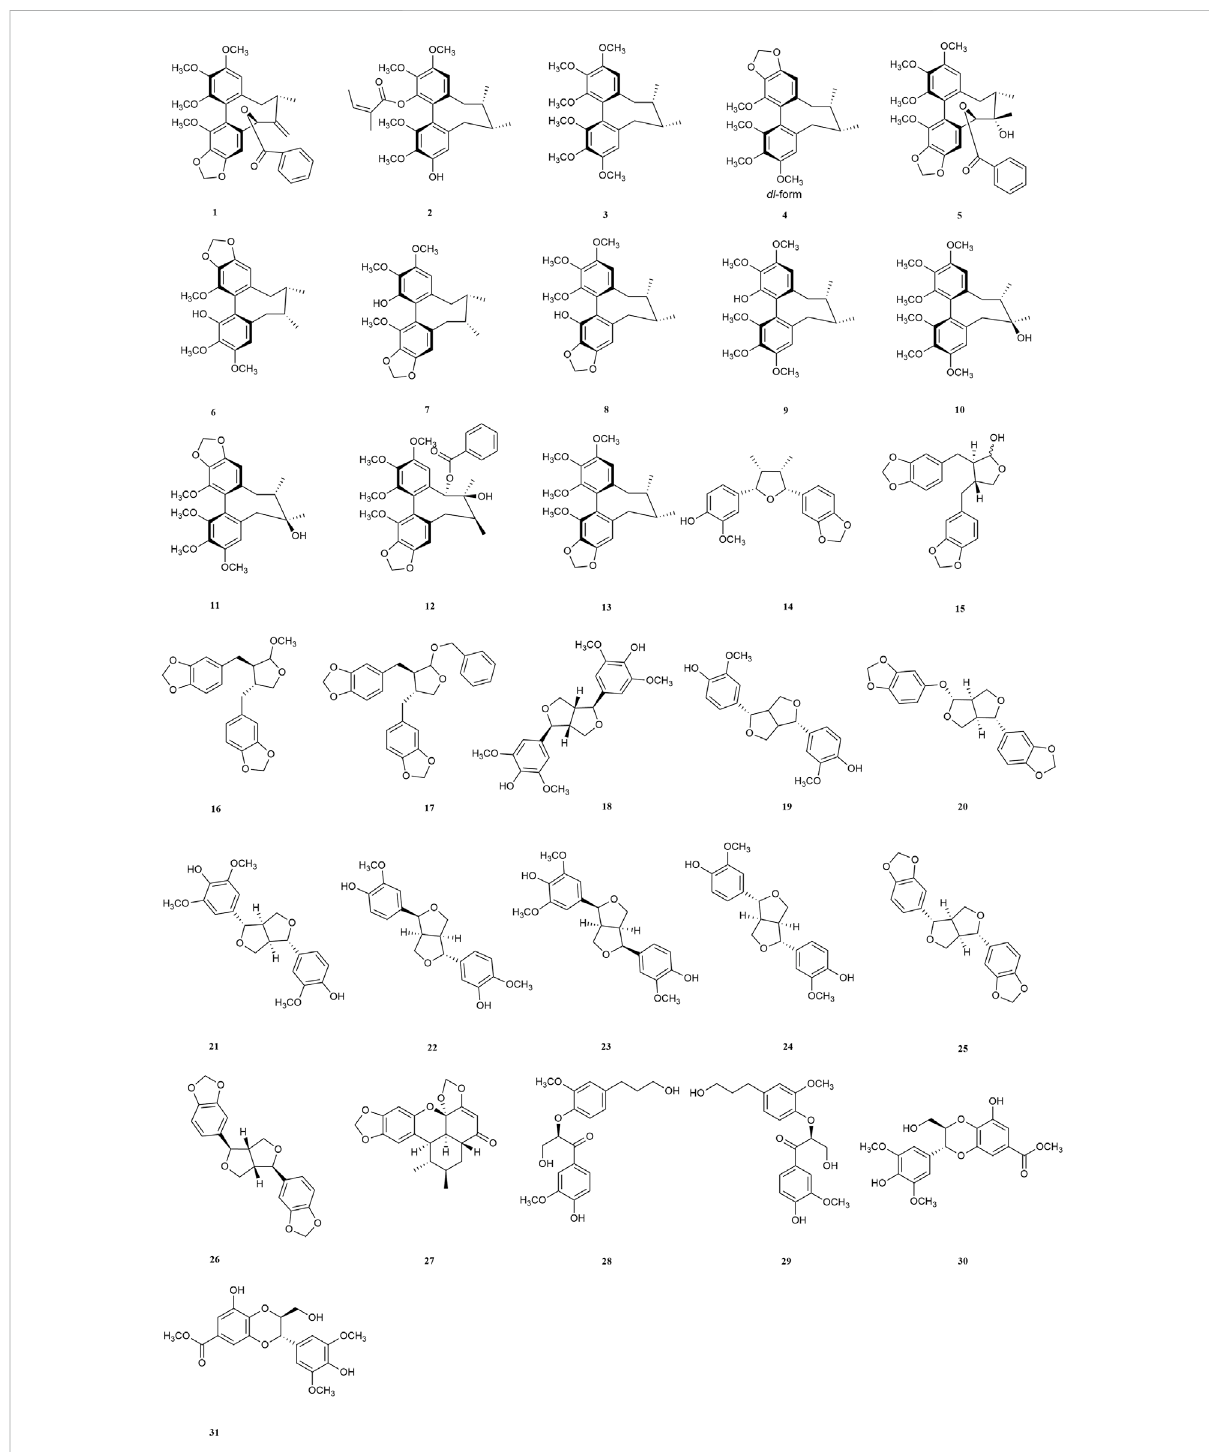
FIGURE 2 Structure of compounds 1 – 31